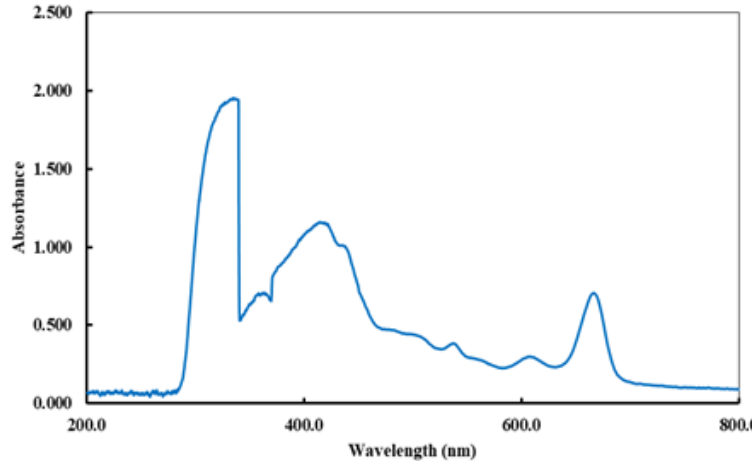
Figure 3. UV-Visible spectrum of